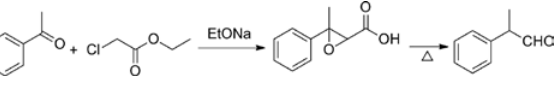
Scheme 1: Synthesizing hydratropic aldehyde by the Darzens reaction.